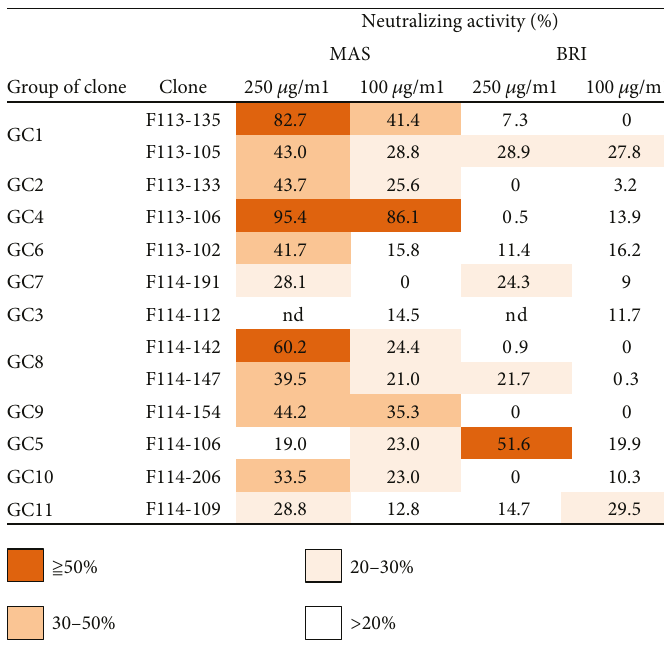
Figure 10: Neutralizing activity. The virus-neutralizing activity of 100 or 250 μ g/ml Fab-pp Ab against B/Massachusetts/2/2012 (MAS) and B/Brisbane/60/2008 (BRI) viruses was examined by the focus reduction test. The focus reduction rate is shown as a percentage. nd indicates not